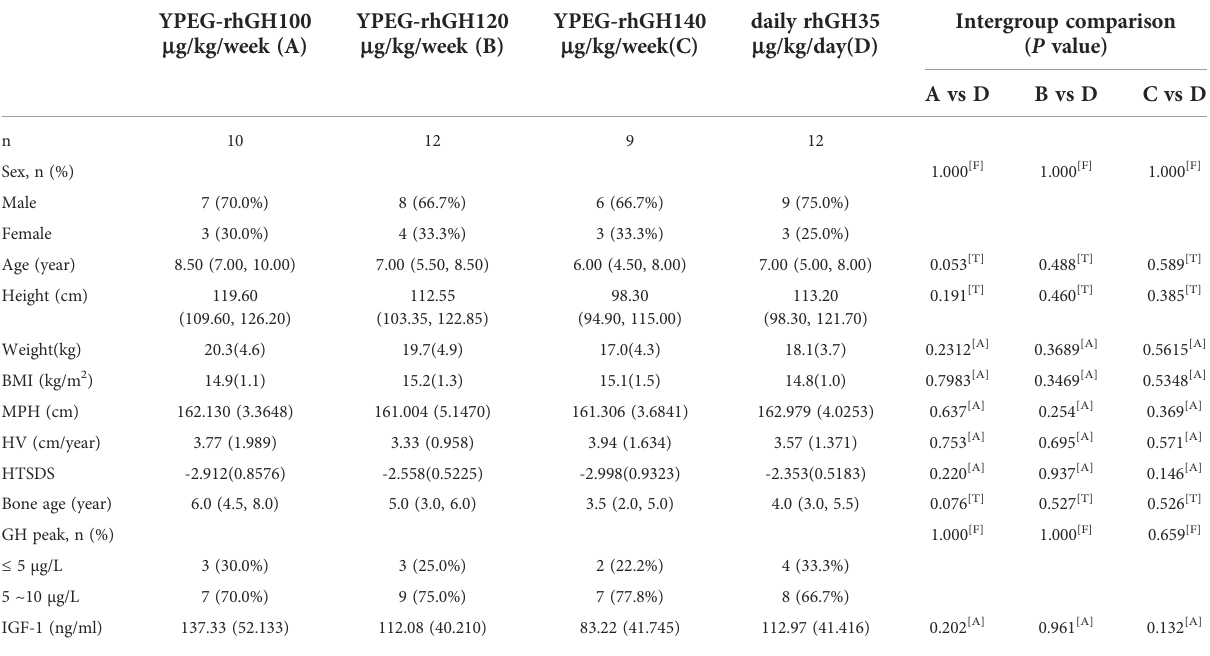
TABLE 3 Patients baseline characteristics in